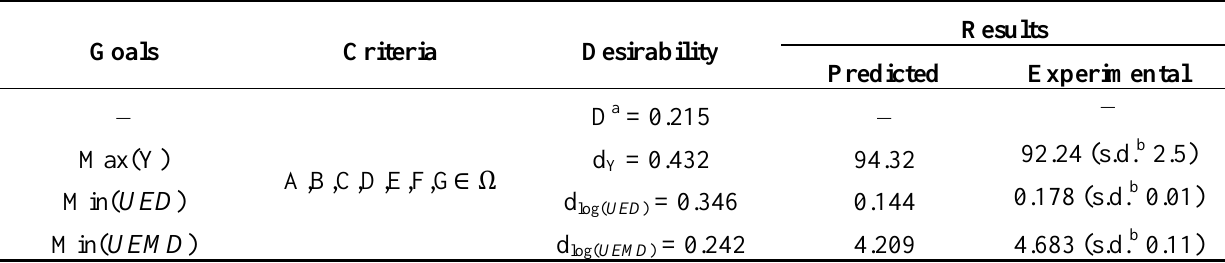
Table 6. Optimization criteria and obtained